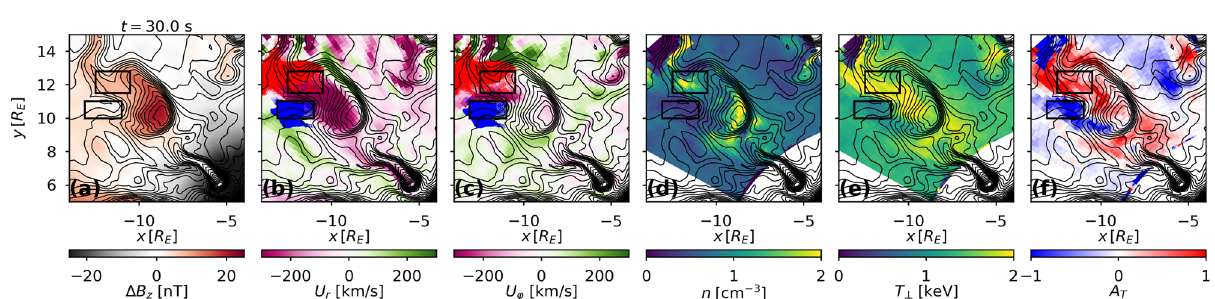
Figure 2. The snapshot of temperature anisotropies in the test-simulations (same as used in obtaining the results shown in Fig. 1), re-initialized with an isotropic kappa distribution with κ 3 , at the end of a 30 s simulation. Panels ( b ) and ( c ) show equatorial projections of test particle n TP 1 c m − = trajectories traced backward in time out of two regions of parallel (blue) and perpendicular (red) electron temperature anisotropies outlined with back rectangles in all the